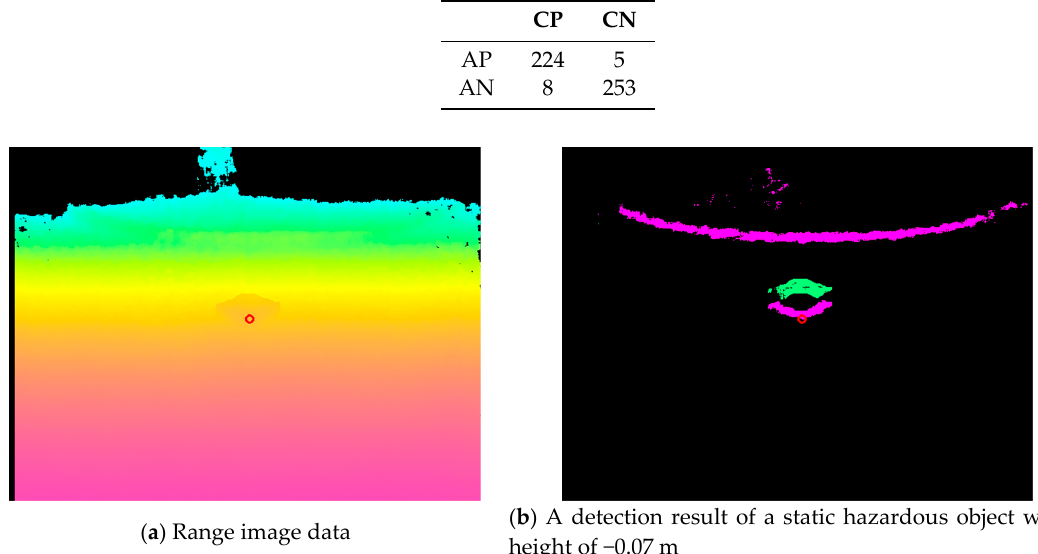
Figure 14. Example of the static hazardous object detection.